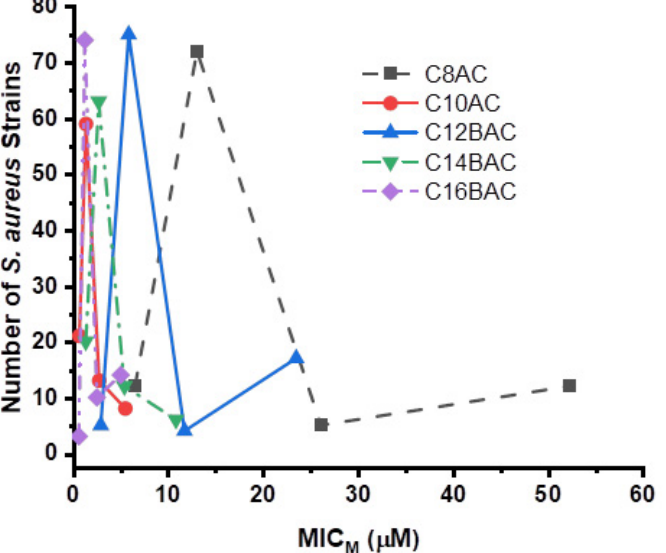
Figure 2. The number of Staphylococcus aureus strains at each molar MIC (MIC M ) for the 101 Staphy- lococcus aureus strains isolated from swine mandibular lymph node tissue and commercial pork sau- sage meat against five ammonium chloride disinfectant